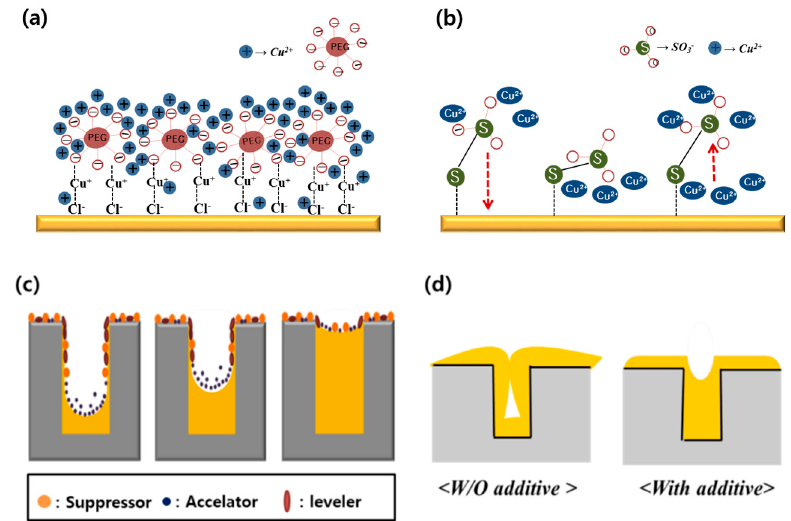
Figure 5. A schematic diagram of additive behavior in plating solution. Action of Cl ion: ( a ) PEG and ( b ) SPS in plating bath; ( c , d ) effect of additive in electrodeposition.